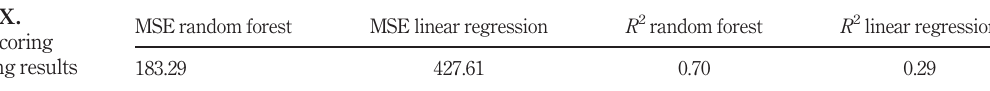
Table X. Pro fi t-scoring modeling